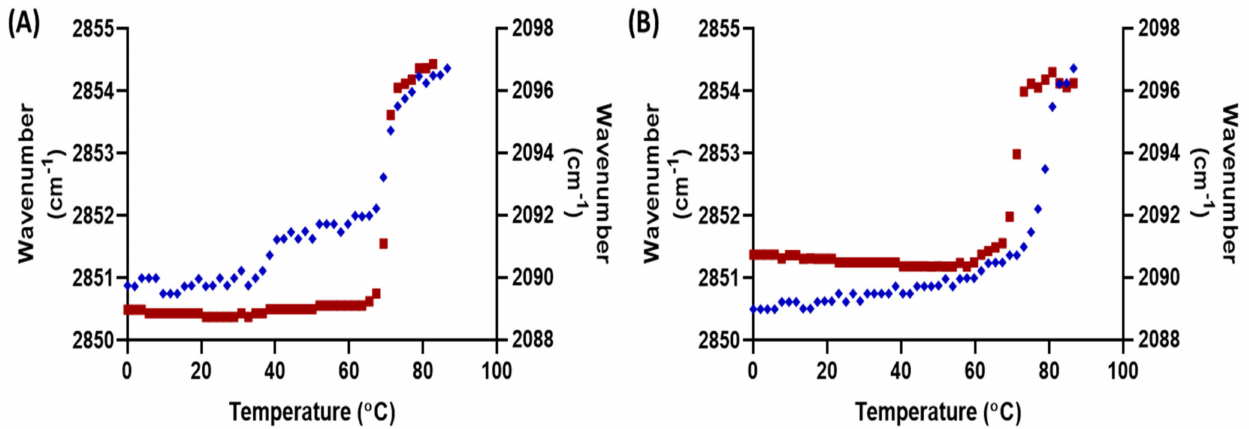
Figure 3. Thermotropic response of ν s CH 2 (blue) and ν s CD 2 (red) of the ( A ) FFA C24 and ( B ) C16 models. The CH 2 and the CD 2 peak positions are plotted on the primary and secondary y-axis’s, respectively, displaying the phase transition temperatures of the ceramide (CER) and dFFA chains in the lipid models. All models contain CERs EOS and NS at a ratio of 40:60. Overall, the composition of CERs, cholesterol (CHOL), and FFAs is in an equimolar